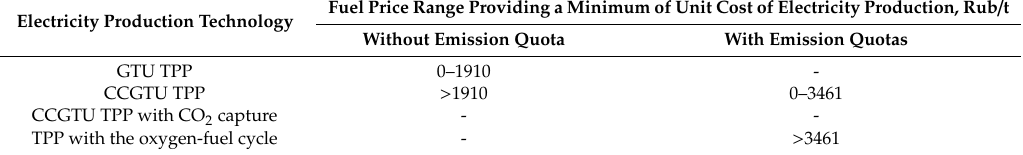
Table 4. Comparison of threshold values for gasified coal prices that determine the economic feasibility of using oxy-fuel combustion